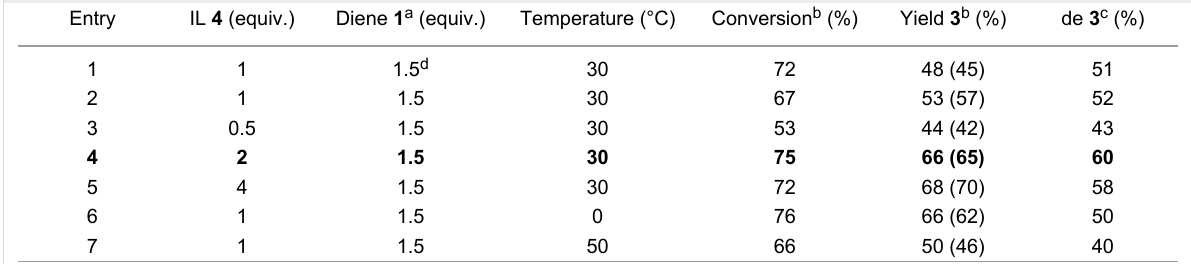
Table 1: Asymmetric aza-Diels-Alder reaction of Danishefsky's diene 1 with aromatic imine 2 (R = Ph) in the presence of chiral IL 4 (X = OH, R' = C 8 H 17 , Y = OTf) for 4.30 hours.